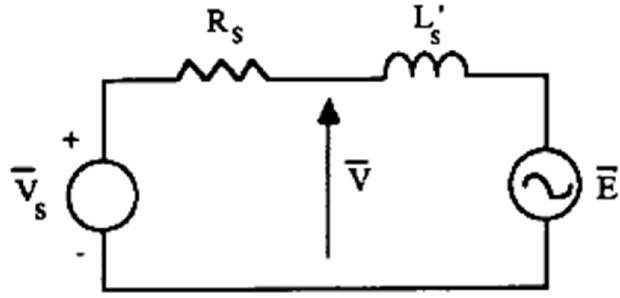
Figure 3. Equivalent circuit of inverter-driven induction motor.